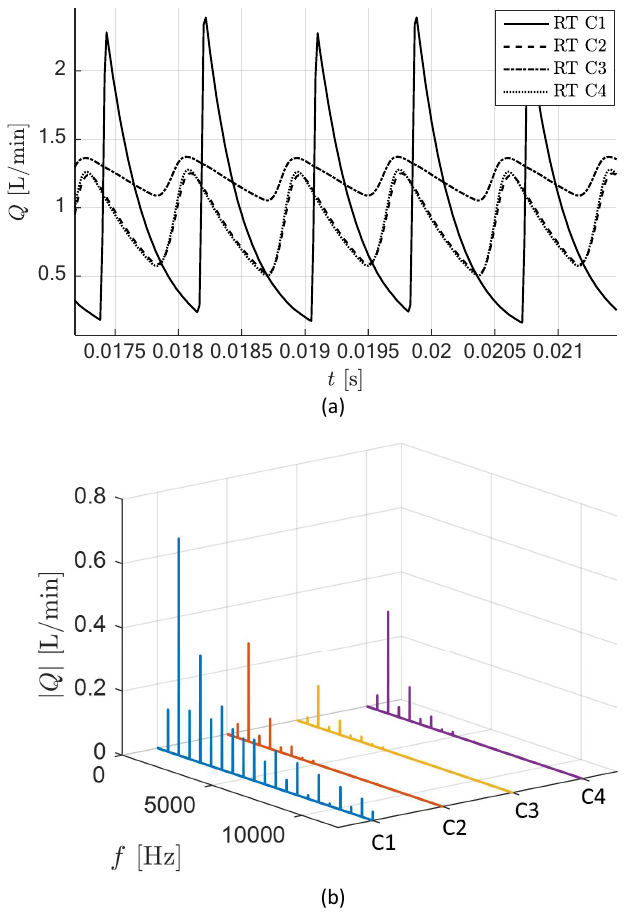
Figure 27: Plots of four pressurization ripple solutions: for Ref EGP, 2000 RPM, 200 Bar, RT circuit, for Figure 27. Plots of four pressurization ripple solutions: for the reference gear pump at 2000 RPM, four different setups, from C1 to C4. Ripples are plotted in (a) time domain and (b) frequency domain 200 bar. The RT circuit is assumed for four different setups, from C1 to C4. Ripples are plotted in up to 10,000 Hz. ( a ) time domain and ( b ) frequency domain up to 10,000 Hz.